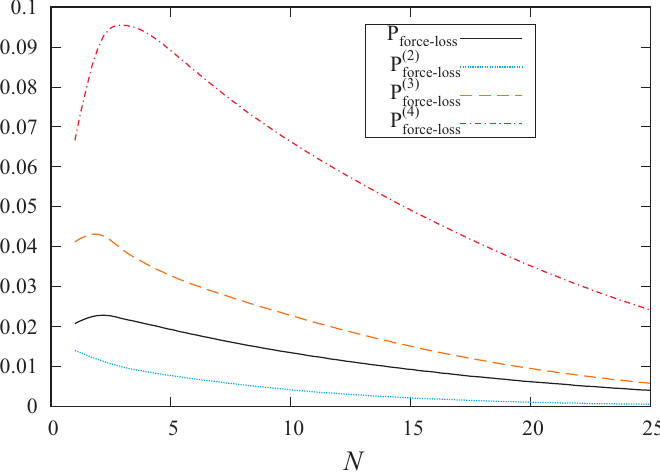
( r ) , r = 2, R , on the buffer force − loss